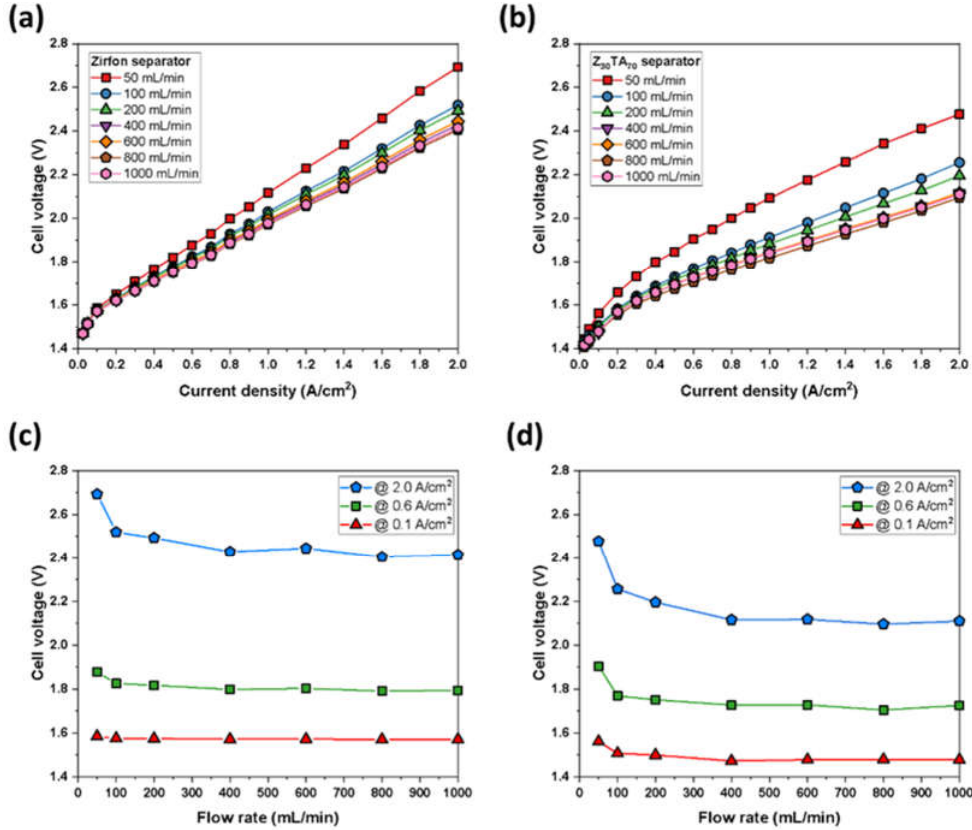
Figure 11. Polarization curves for an electrochemical cell using Raney nickel as the cathodic and Ni-Fe LDH as anodic electrode, respectively, at various KOH flow rates ( a ) Zirfon ® and ( b ) Z 30 TA 70 separator membrane. Effect of KOH flow rate on cell voltage at different current densities ( c ) Zirfon ® and ( d ) Z 30 TA 70 separator membrane.